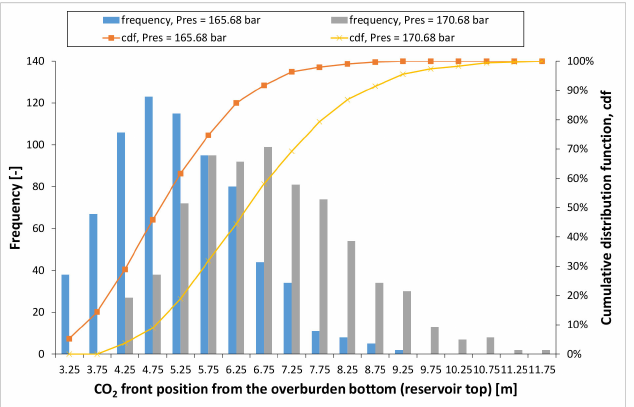
Figure 21. Histogram of CO 2 front position from the overburden bottom 500 years after the end of injection for Ensemble no. 1 (P ini1,s = 165.68 bar) and for Ensemble no. 2 (P ini2,s = 170.68